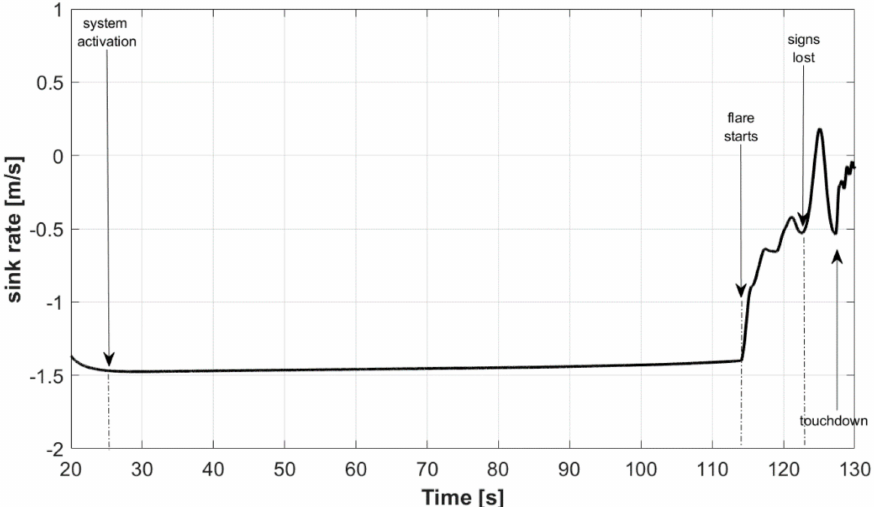
Figure 20. Vertical speed of the aircraft during all sections of the landing.